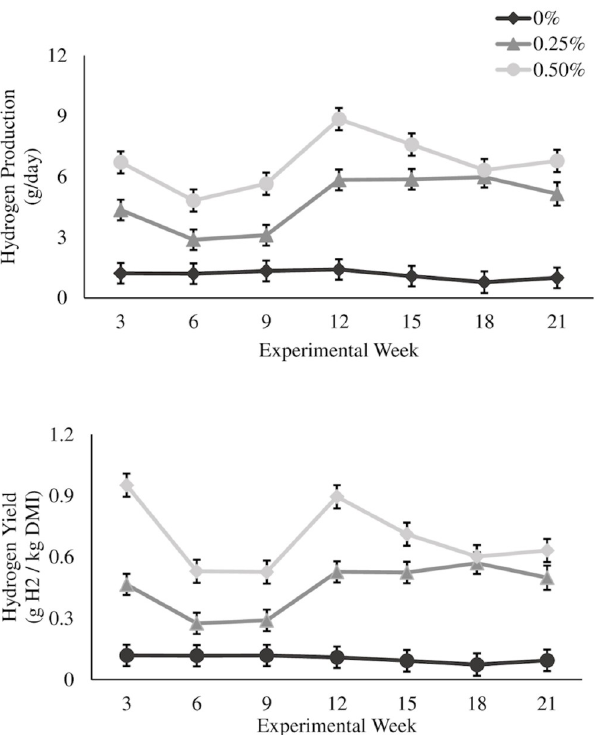
Fig 4. Asparagopsis taxiformis inclusion effects on hydrogen emissions during the 21-week experimental period. Hydrogen production [g H 2 /day] (A) and Hydrogen yield [g H 2 /kg DMI] (B) from beef steers supplemented with Asparagopsis taxiformis at 0%, 0.25%, and 0.5% of basal total mixed ration on an organic matter basis during the 21 week experimental period. Data points are treatment means for each gas collection timepoint and error bars represent standard